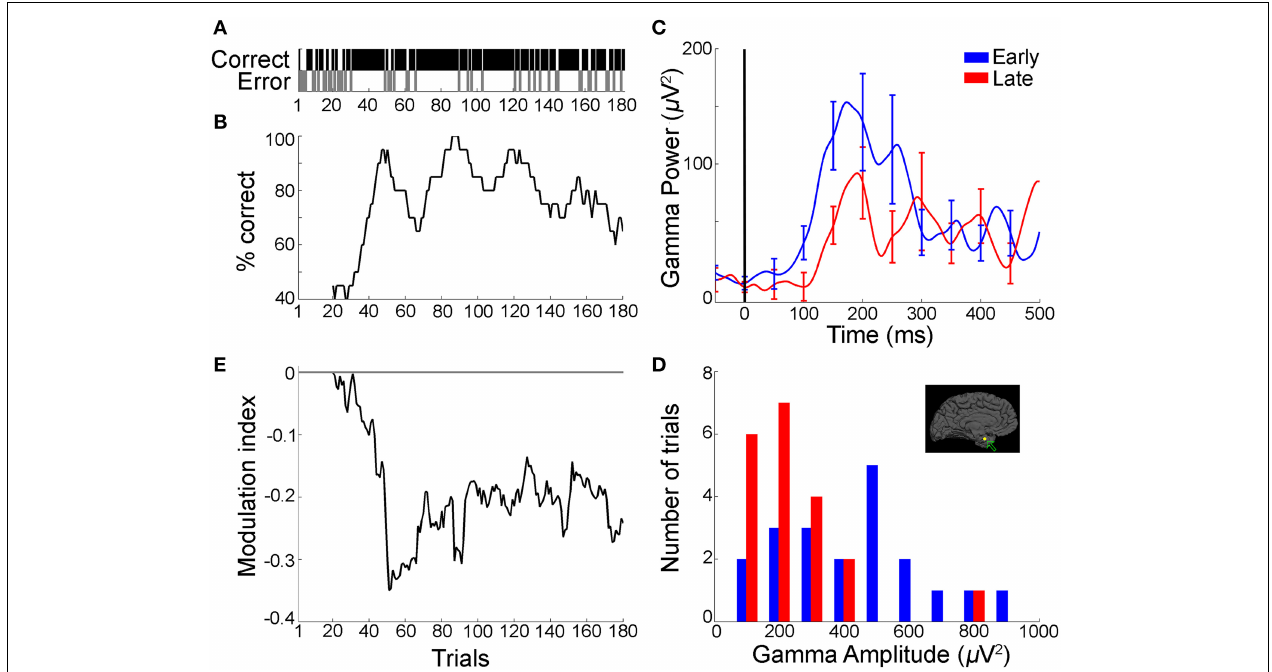
FIGURE 2 | Gamma frequency band power during the recall phase decreased with improved sequence learning over trials (example from Task 1). (A) Behavioral profile of a representative subject during sequence learning in Task 1 showing performance (correct, black; error, gray) at each trial ( n = 182 trials). (B) Associated learning curve computed by using a sliding window of 20 trials stepped by one trial. (C) Mean gamma frequency band power (30–100Hz) averaged over the first (“early,” blue) and last (“late,” red) 20 trials in the session, for an electrode in the left parahippocampal gyrus (Talairach coordinates: − 19.2, − 4.6, − 30.2; inset in part d depicts electrode position). Data are aligned to choice screen presentation at t = 0. Error bars represent SEM and are shown every 50ms for clarity. (D) Distribution of peak-to-peak gamma frequency band amplitudes (Gamma-band amplitude = max [Gamma-band